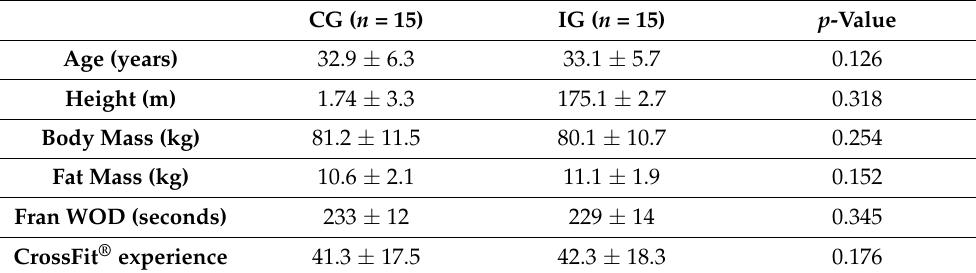
Table 1. Participant’s Anthropometric and Exercise Performance